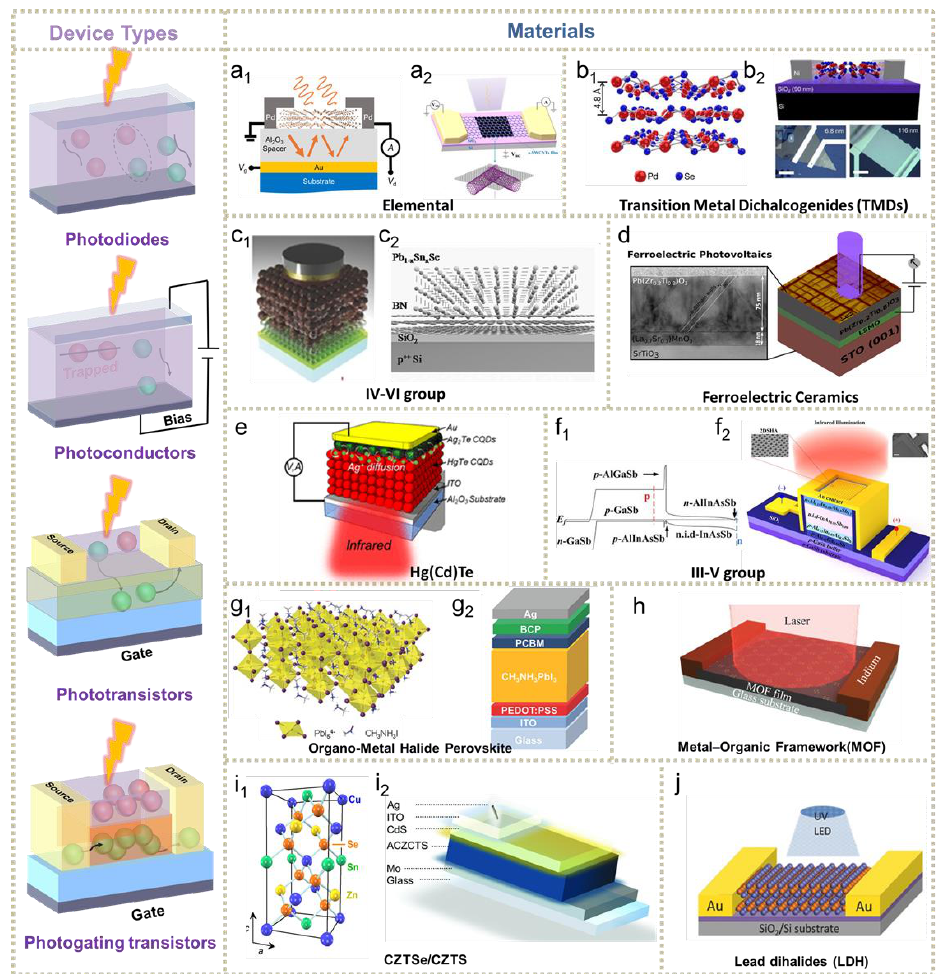
Figure 2. Fundamental devices configuration and materials categories with cooling-enhanced photo- electric performance. ( a ) Elemental semiconductors. ( a 1 ) Tellurium nanoflakes (adapted from [47], with permission from the American Chemical Society, 2018). ( a 2 ) Graphene (adapted from [48], with permission from the American Institute of Physics, 2018). ( b ) Transition metal dichalcogenide (adapted from [49], with permission from the American Institute of Physics, 2019). ( c 1 ) PbS (adapted from [50], with permission from Wiley-VCH, 2014). ( c 2 ) Pb 1 − x Sn x Se (adapted from [51], with permis- sion from Wiley-VCH, 2015). ( d ) Ferroelectric ceramics (adapted from [52], with permission from the American Chemical Society, 2020). ( e ) Hg(Cd)Te (adapted from [53], with permission from the American Chemical Society, 2018). ( f ) III-V group. ( f 1 ) Band alignment of p-i-n structure. ( f 2 ) p-i-n structure (both adapted from [54], with permission from the American Institute of Physics, 2018). ( g ) Organo-metal halide perovskite. ( g 1 ) Crystal structure (adapted from [55], with permission from Wiley-VCH, 2016). ( g 2 ) Planar perovskite solar cells (adapted from [31], with permission from Wiley- VCH, 2017). ( h ) Metal-organic framework, reproduced with permission [20], from Wiley-VCH, 2020). ( i ) CZTSe/CZTS solar cells. ( i 1 ) Crystal structure (adapted from [56], with permission from Elsevier, 2017). ( i 2 ) CZTS planar solar cells (adapted from [57], with permission from Wiley-VCH, 2018). ( j ) Lead dihalides (adapted from [58], with permission from Wiley-VCH,